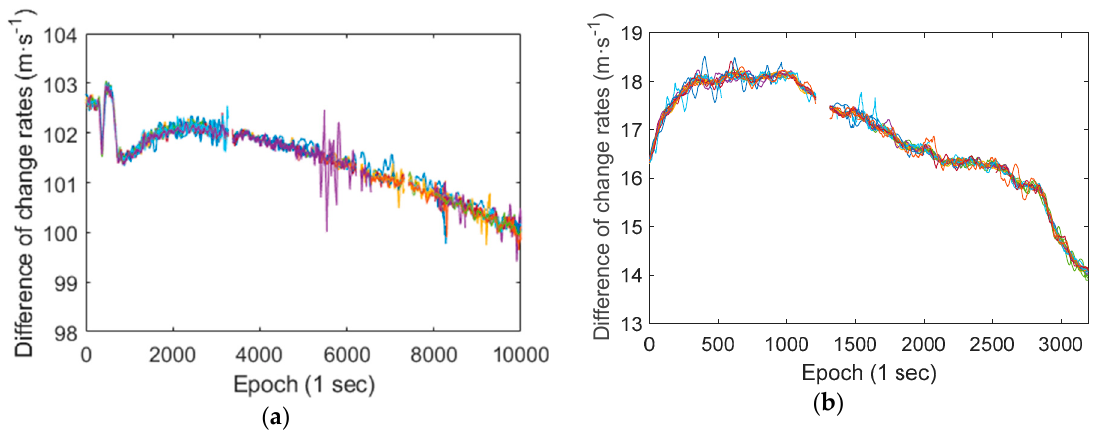
Figure 5. The di ff erences between pseudorange change rate and carrier phase change rate of all GNSS satellites of a Huawei P10 smartphone and a Xiaomi MI 8 smartphone (L1 / E1 frequency). ( a ) Huawei P10 smartphone; ( b ) Xiaomi MI 8 smartphone (L1 / E1 frequency).